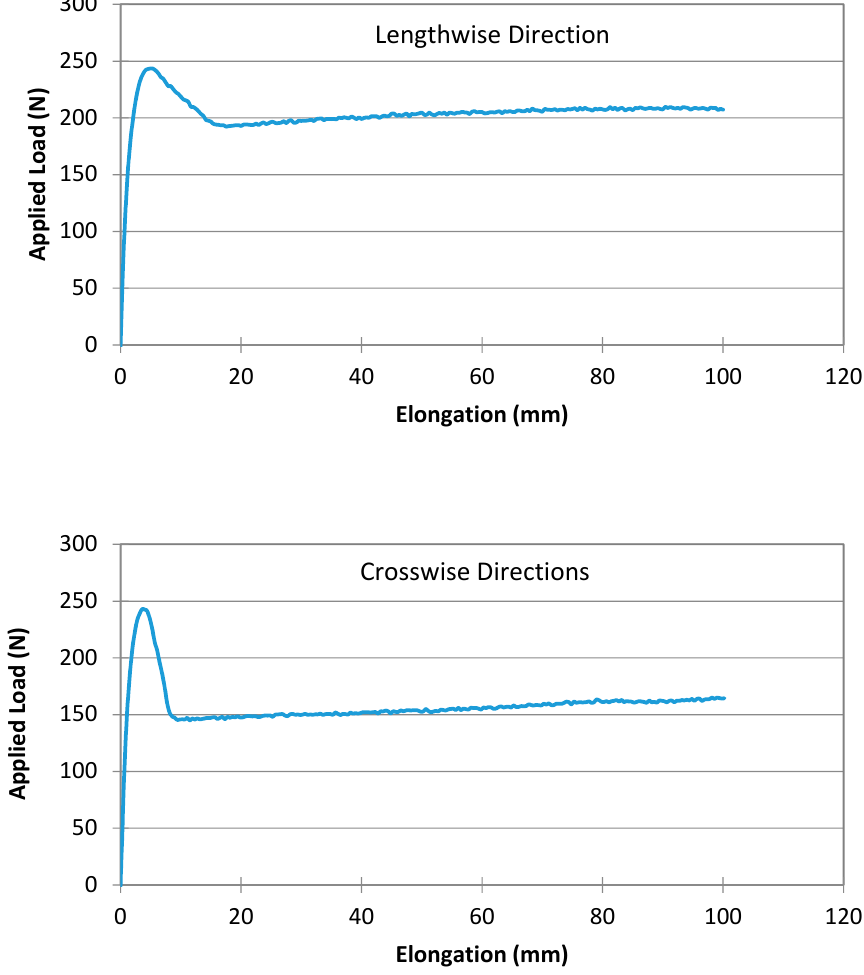
Figure 5. HDPE tension test results in the lengthwise and crosswise directions.